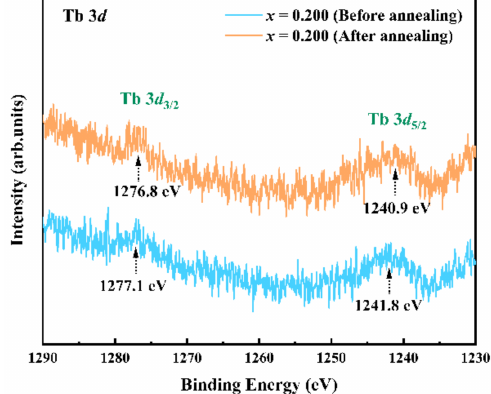
Figure 5. XPS Tb 3 d core-energy-level spectrum.